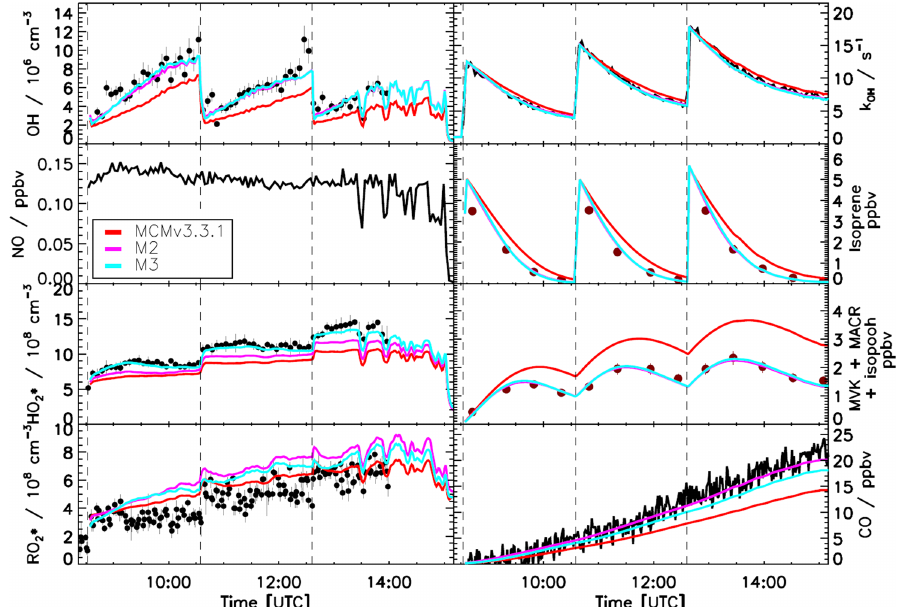
Figure 5. Comparison of modelled and measured trace gases for an experiment with NO < 0 . 2ppbv. Measured time series of radicals and OH reactivity (LIF), isoprene and MVK + MACR + ISOPOOHs (GC), and CO (Picarro) are compared to model calculations. Vertical dashed lines indicate the times when isoprene was injected. Good agreement is observed when using M2 or M3 (Table 2), which use a different yield for HPALD of 0.40 and 0.75, respectively. Within both models, ∼ 50% of isoprene-RO 2 radicals (weighted by their abundance) are lost via isomerization reactions. Error bars represent 1 σ standard